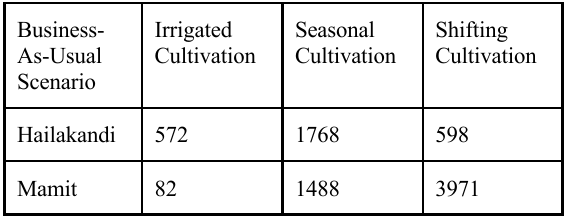
Table 4. Number of land parcels of 25 ha each under various forms of land use in the business as usual scenario for the year